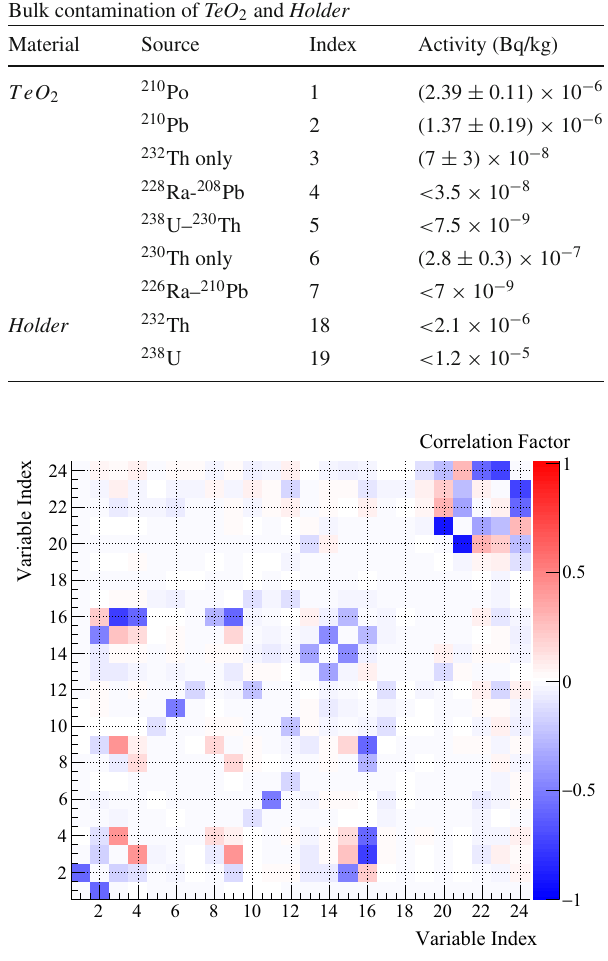
Fig. 3 Correlation matrix among the activities evaluated in the CUORE-0 background reconstruction. The list of sources is reported in Tables 5 and 6 with their Index